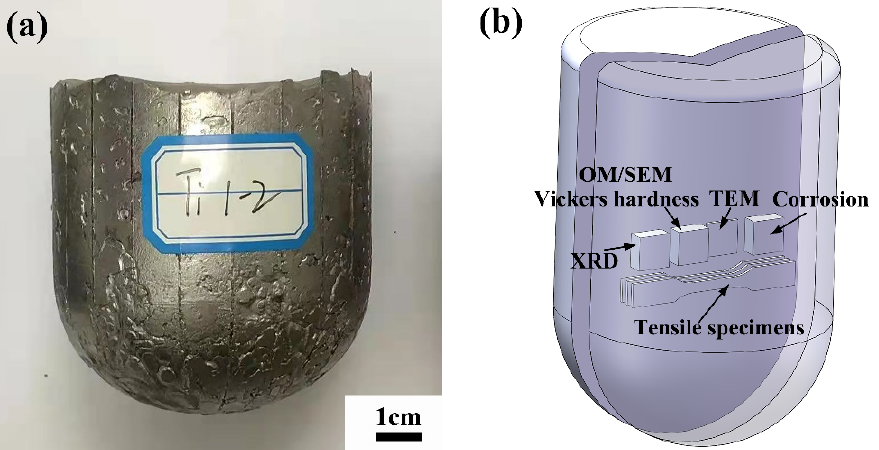
Figure 1. ( a ) Ti-Cu alloy ingot and ( b ) schematic of the sampling locations for microstructure observations, tensile and corrosion testing.